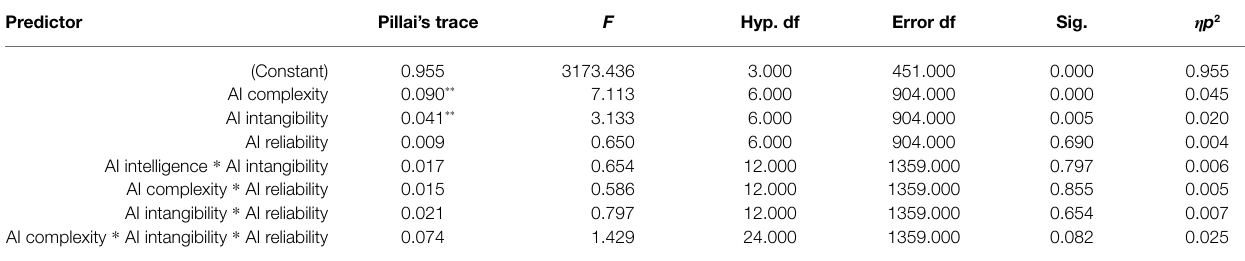
TABLE 1 | Multivariate tests. Predictor